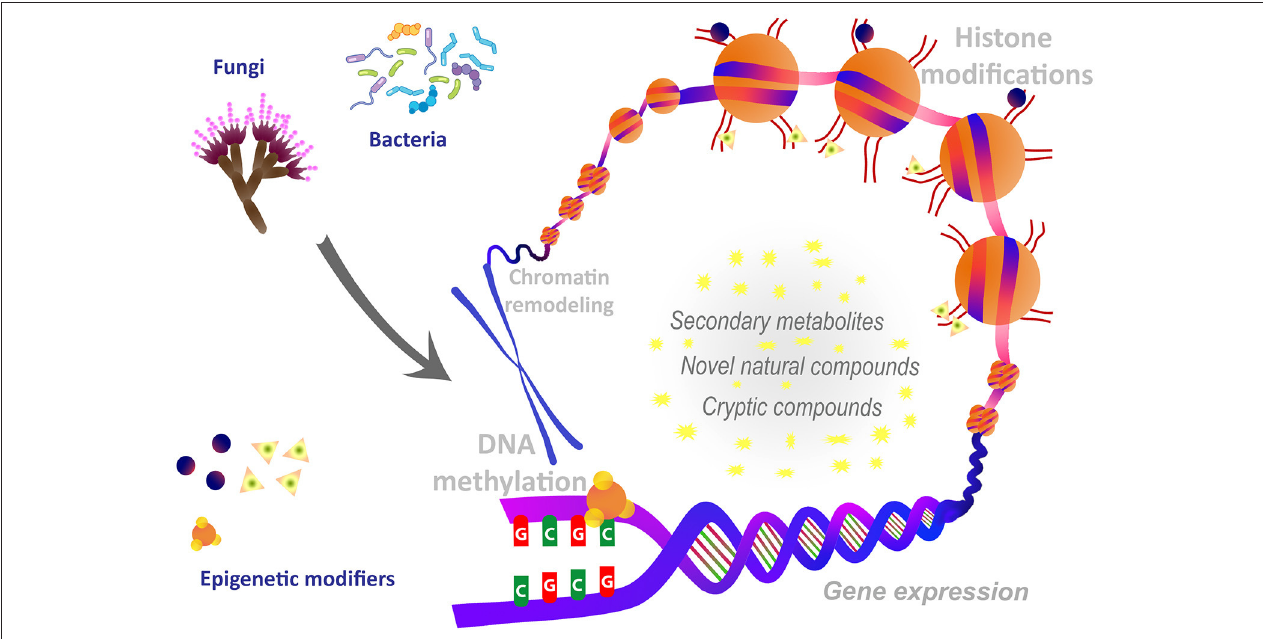
FIGURE 1 | Epigenetic tailoring in